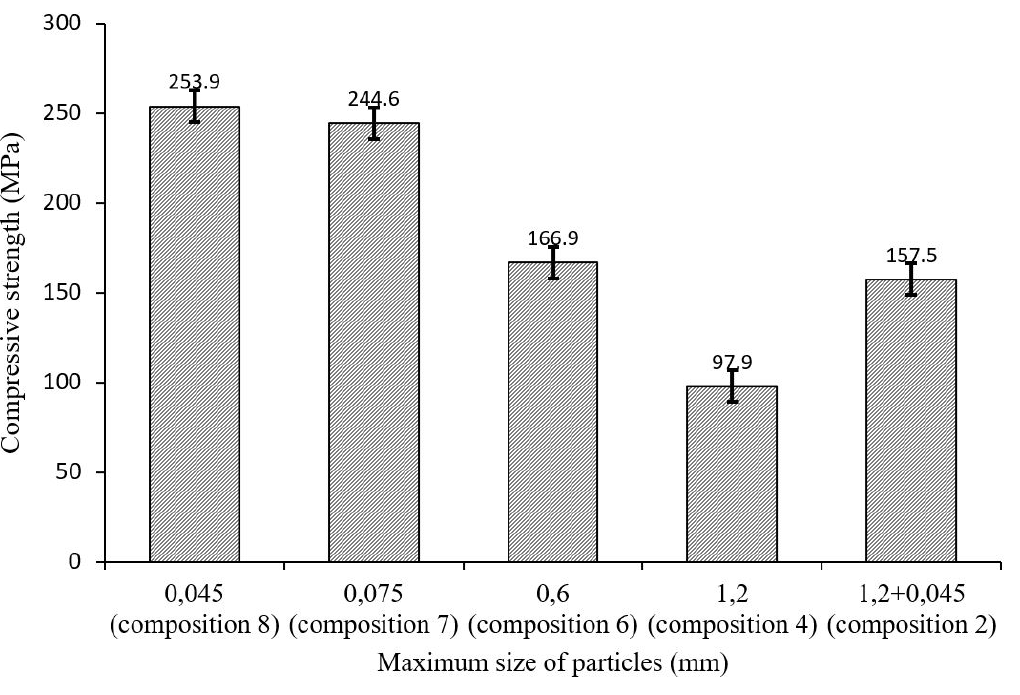
Figure 4. Influence of MAS (Maximum aggregate size) of the aggregate in RPC with 0.25 w/c ratio – Phase 1.